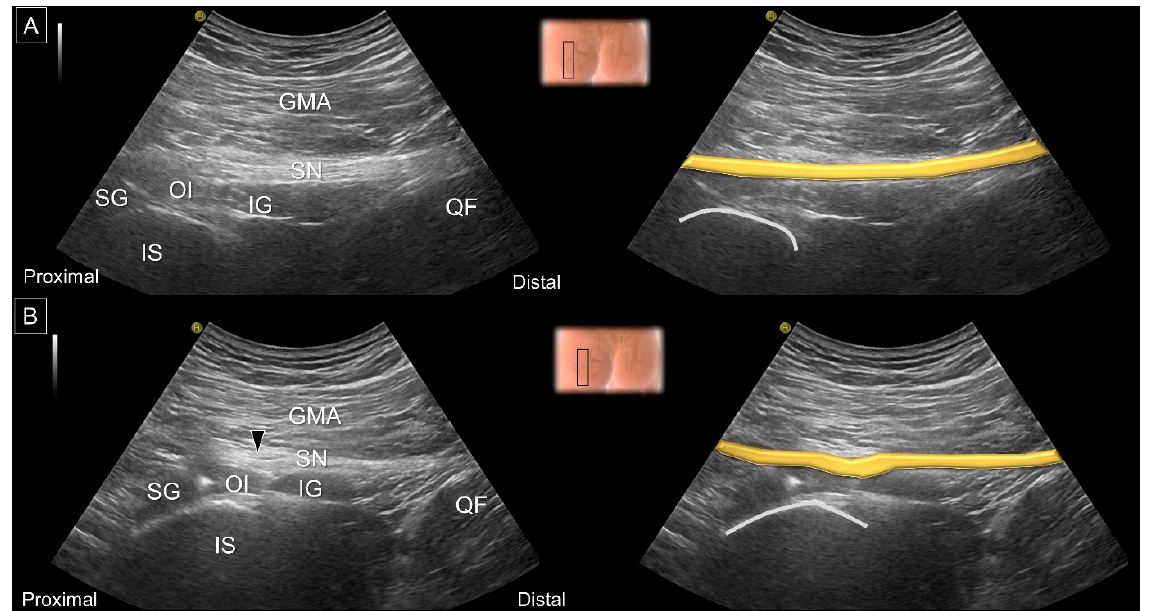
Figure 13. US images and schematic drawings of the sciatic nerve (SN, yellow color) in its long axis in the ( A ) neutral position and ( B ) with hip internal rotation. GMA: gluteus maximus muscle; SG: superior gemellus muscle; IS: ischial spine; OI: obturator internus muscle; IG: inferior gemellus muscle; QF: quadratus femoris muscle; arrowhead, kinking of the sciatic nerve.